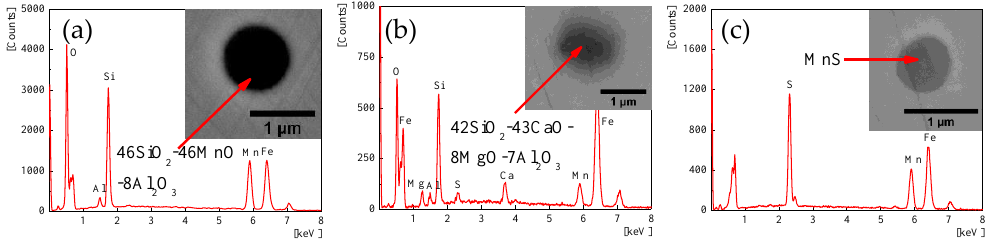
Figure 11. Typical inclusions in steel which were treated by adding Na 2 O in synthetic refining slag. Metals 2018 , 8 , x FOR PEER REVIEW